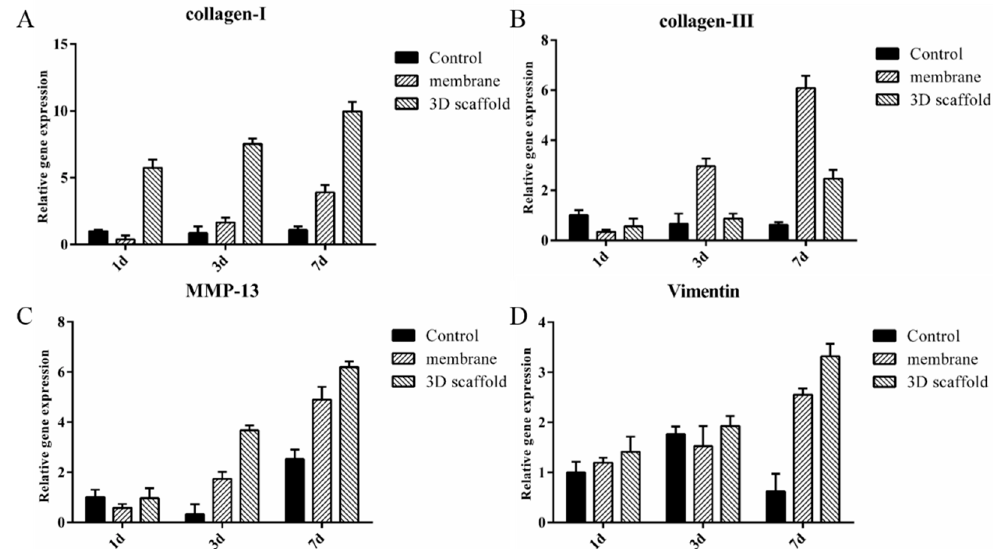
Figure 7. Expression of: ( A ) collagen I, ( B ) collagen III, ( C ) MMP-13, and ( D ) vimentin in nanofibrous membranes, 3D nanofibrous scaffolds and culture dishes as measured by RT-PCR. Bars represent mean ±SD, number of repeats n = 3.